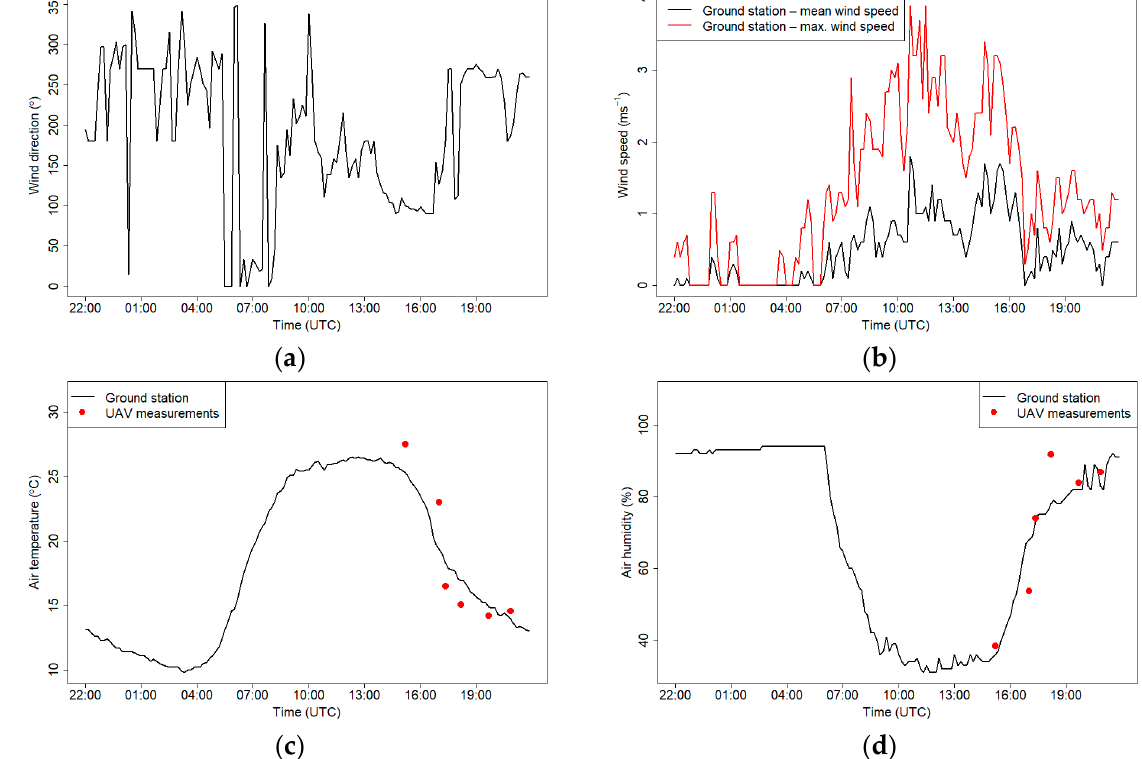
Figure 10. Wind direction ( a ), wind speed ( b ), air temperature ( c ) and relative humidity ( d ) measured at the JU Campus meteorological station on 18 September 2018. Red dots show measurements from the drone that were made at the start of each flight.